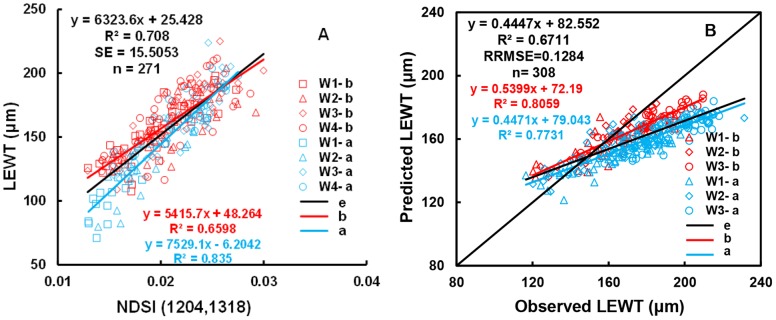
Quantitative relationships between NDSI (R1204, R1318) and LEWT (A); the 1∶1 relationship between the predicted and observed LEWT based on NDSI (R1204, R1318) (B).